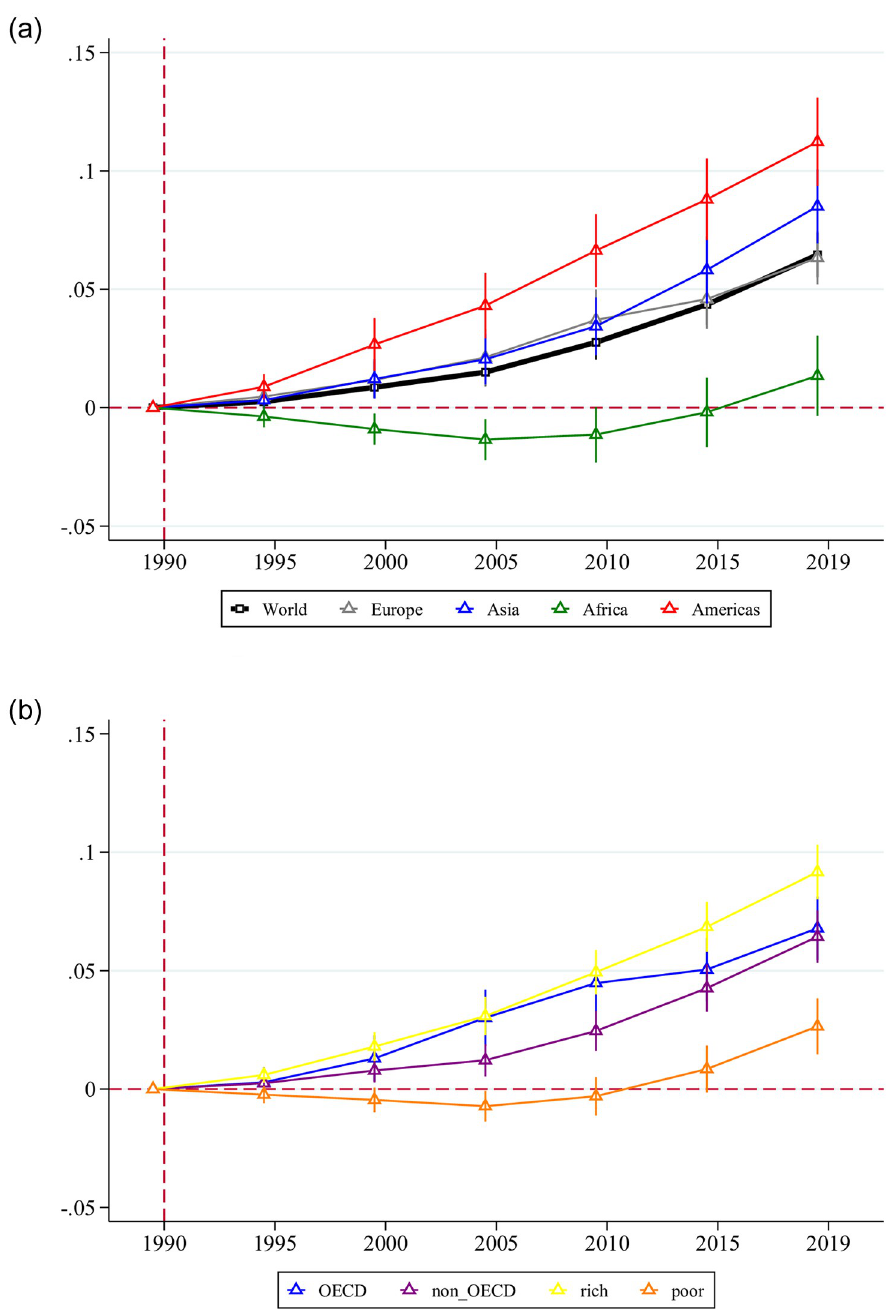
Fig 4. Physiological aging of the workforce. Notes: This figure plots the estimates from regressing logged deficits of the average worker on period dummies (i.e., 1990, 1995, 2000, 2005, 2010, 2015, 2019), where 1990 is the omitted period of comparison for all samples, along with their 95% confidence bands. Left: sample split by continent. Right: sample split by level of economic development.